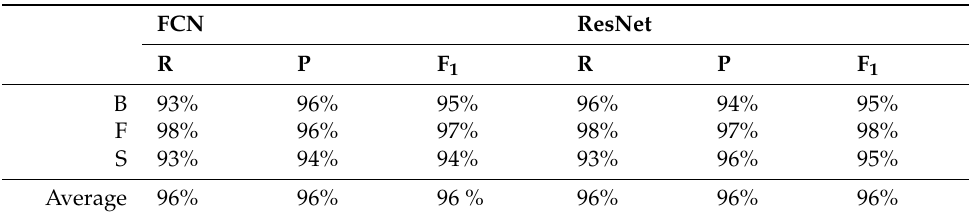
Table 3. Recall (R), precision (P), and F 1 score (F 1 ) for FCN and ResNet for the respective shot types of the best model.